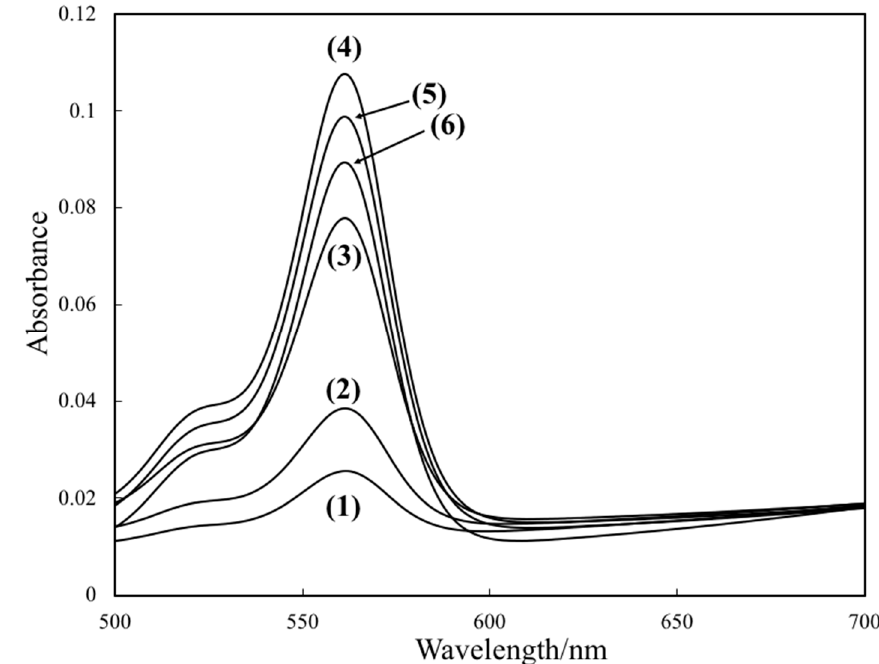
Figure 1. The absorption spectra of the lactone-rhodamine B (L-RB) film after it was immersed to a NaTPBF solution (pH 4.0, adjusted with a 0.1 M CH 3 COOH/CH 3 COONa buffer solution) for 30 min, respectively. Concentration of NaTPBF: (1) 0 μ M, (2) 1.0 μ M, (3) 5.0 μ M, (4) 10.0 μ M, (5) 50.0 μ M, and (6) 100.0 μ M.